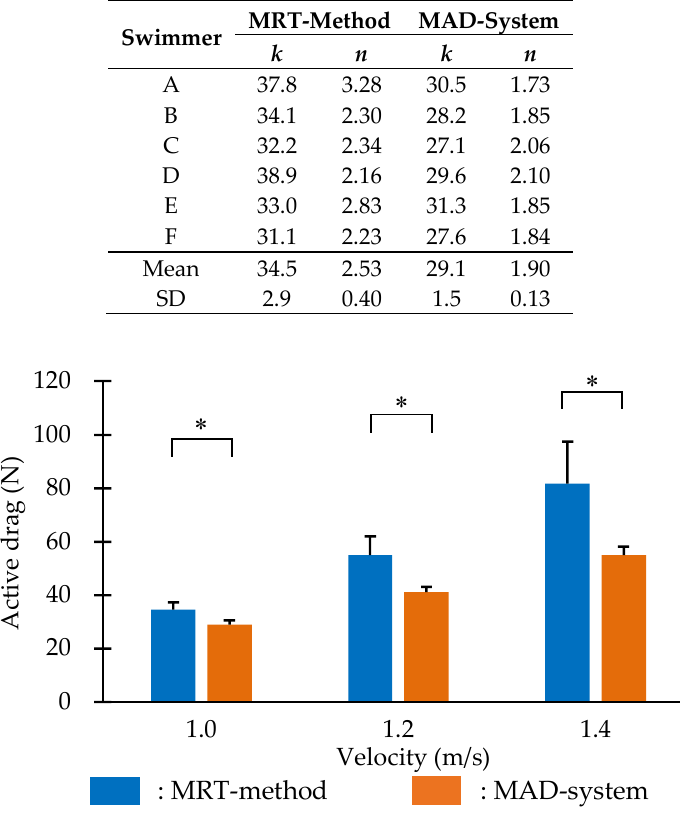
Figure 3. The average values of active drag at 1.0, 1.2 and 1.4 m/s in MRT-method (blue) and MAD- system (orange). Asterisk (*) indicates a significant difference between MRT-method and MAD- system, p 